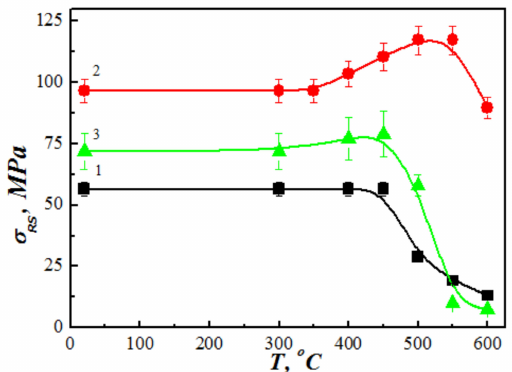
Figure 8. Effect of tempering temperature T on residual tensile stresses σ RS in coatings obtained by spraying CWs with different charge compositions: C1.4Cr14B3NiTi2Al (1), C0.2Cr18B3Ti2Al (2), C1.4Cr14Ni2Ti2Al (3).